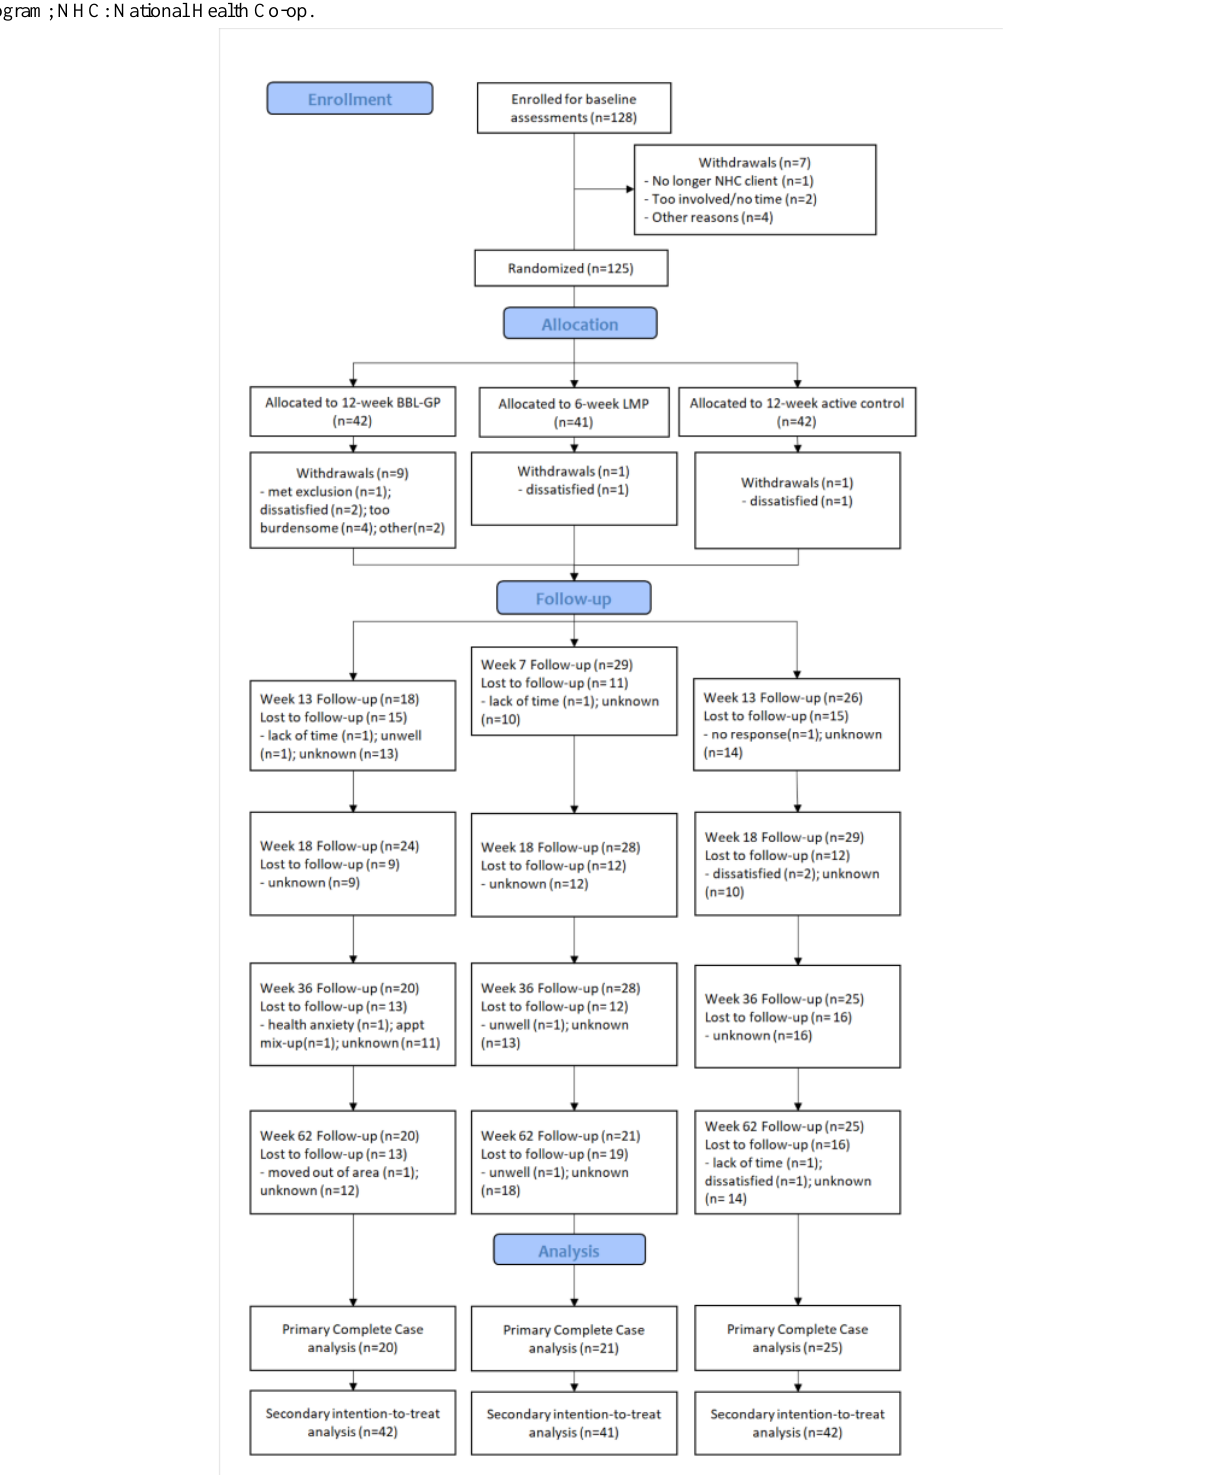
Figure 1. Participant flow through the trial, follow-up, and analysis. BBL-GP: Body Brain Life in General Practice; LMP: Lifestyle Modification Program; NHC: National Health